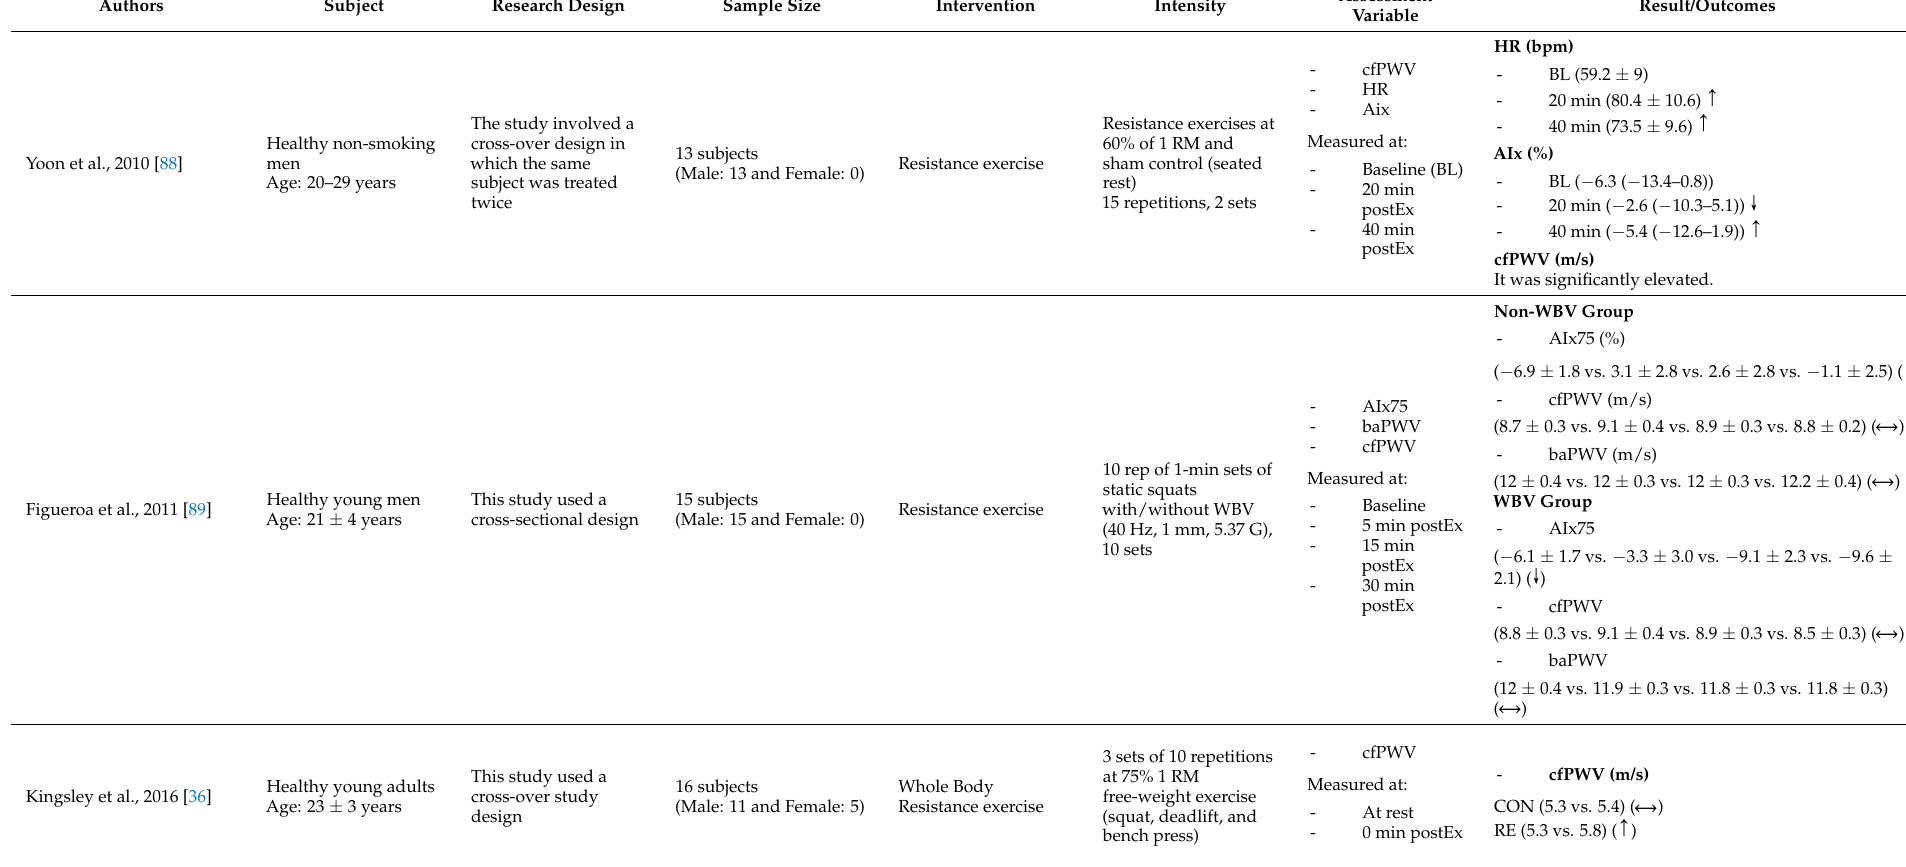
Table 2. Effect of aerobic exercise training on arterial stiffness. Table 3. Effects of resistance exercise training on arterial stiffness. Table 1. Summary of the associations between metabolic impairments and arterial stiffness.